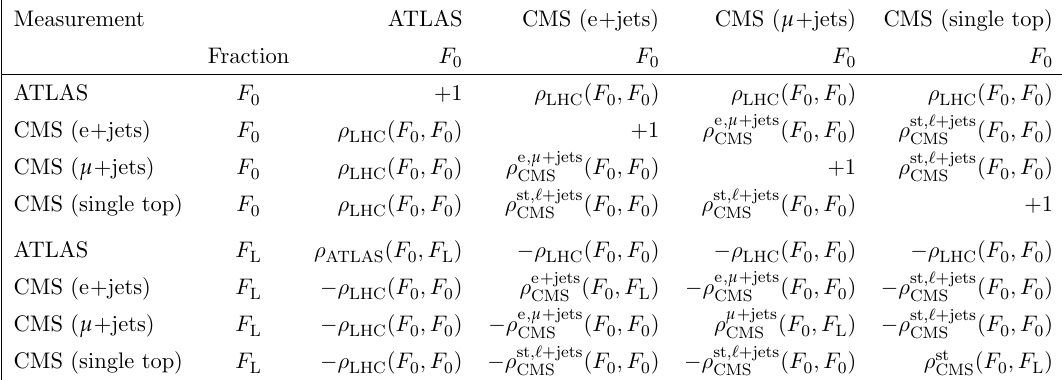
Table 5 . Summary of the correlation categories considered in the combination. The correlations among the F measurements are not shown for L